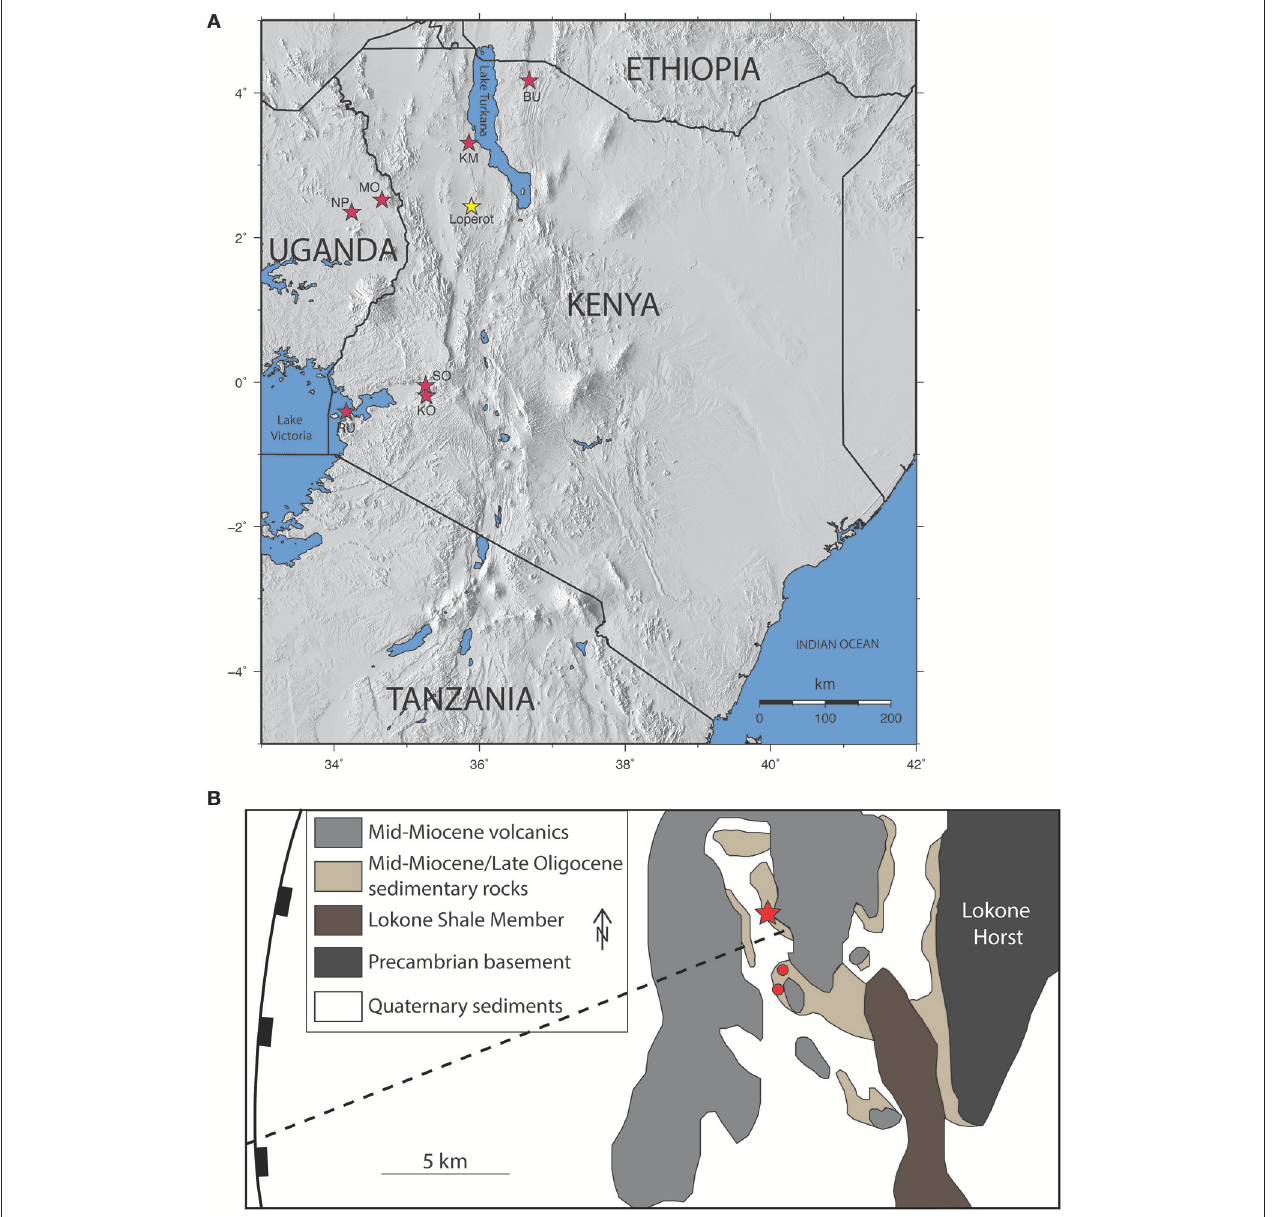
FIGURE 1 | (A) Regional map of East Africa, showing the location of Loperot (west Turkana) in relation to other important Miocene catarrhine sites, including Rusinga Island (RU), Koru (KO), Songhor (SO), Napak (NP), Moroto (MO), Kalodirr and Moruorot (KM), and Buluk (BU). (B) Detailed geologic map of the Lokichar Basin, showing exposed Oligocene and Miocene deposits to the west of the Lokone Horst and to the east of the border fault; modified from Morley et al. (1999b). Dashed line indicates the cross-section shown in Figure 2A . Red star denotes site LpM4; red dots identify the locations of sites LpM2 (southern) and LpM3 (northern).